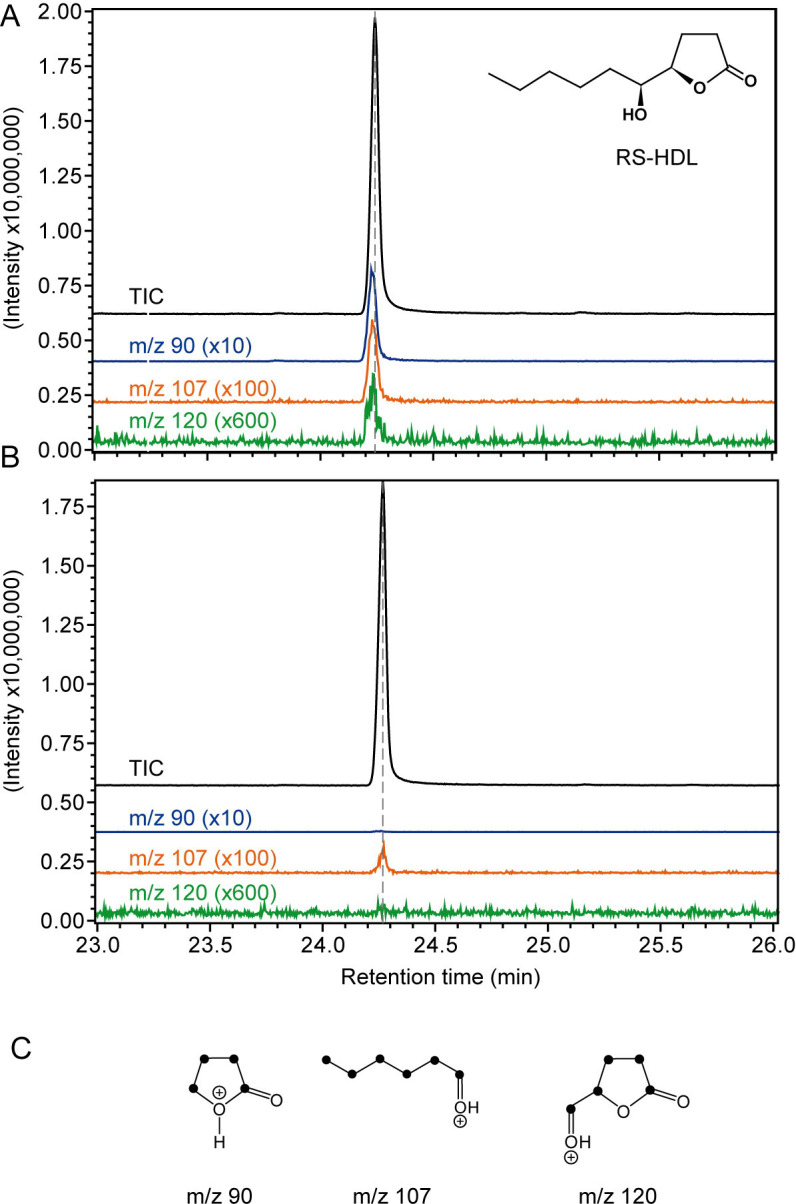
Results of the 13C-labeling experiments.GC/MS analysis of pheromone extracts from (A) male Nasonia giraulti wasps treated with an acetone solution containing fully 13C-labeled linoleic acid and (B) control males treated with pure acetone. Shown are the total ion current chromatograms (TIC) and the extracted ion chromatogram of the diagnostic ion m/z 90, 107, and 120 (magnification factors given in parentheses) indicating the incorporation of the 13C-labeled precursor into the sex pheromone component (4R,5S)-5-hydroxy-4-decanolide (RS-HDL). The dotted lines indicate the peak maxima of the TIC to illustrate the slightly decreased retention time of the diagnostic ions due to the inverse isotope effect of heavier isotopes. (C) Structures of monitored diagnostic ions (black dots indicate 13C-atoms).